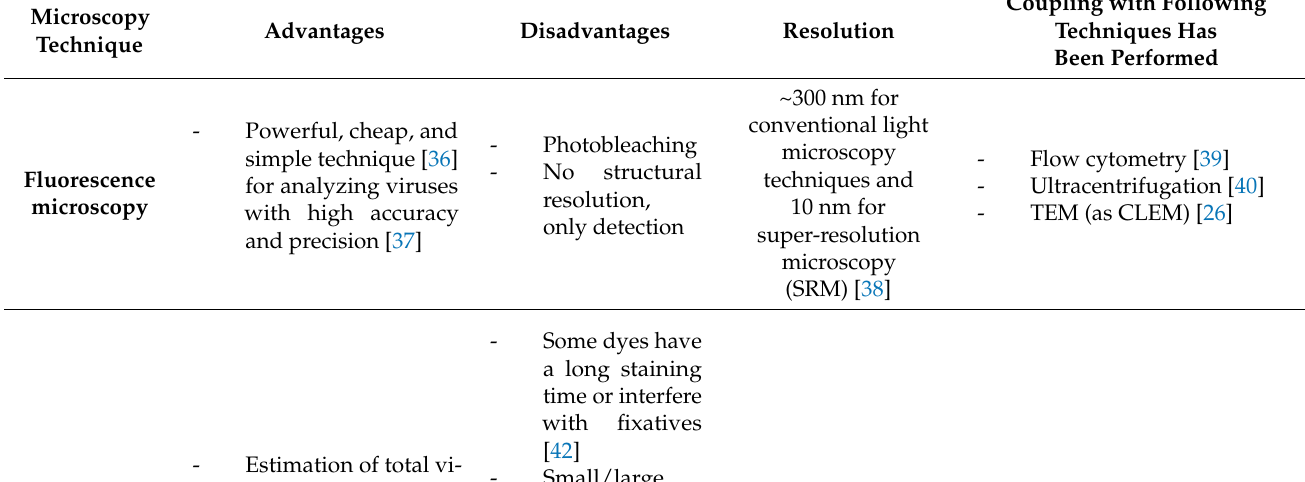
Table 1. Overview of frequently used microscopy methods for studying viral abundance, viral morphology, and viral